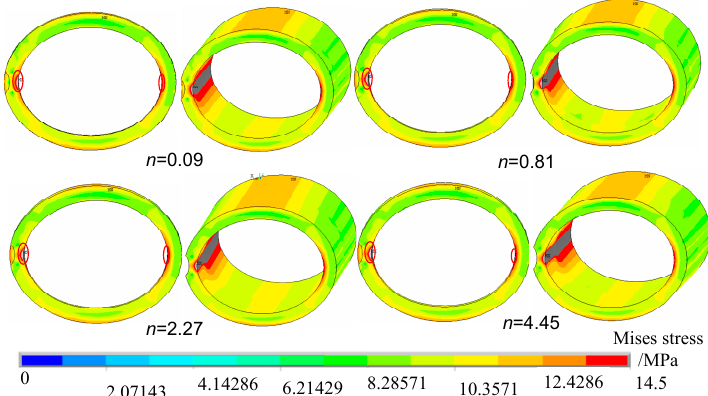
Figure 20. Location of HDPE pipeline failure with various defect lengths.